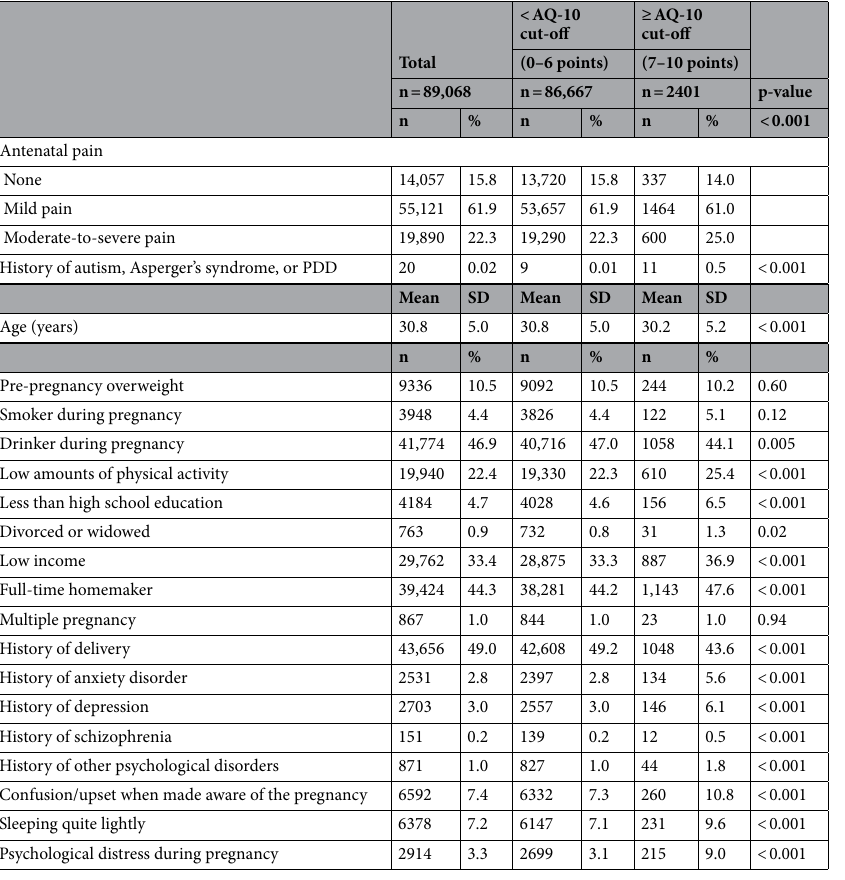
Table 1. Participants’ characteristics by the Autism-Spectrum Quotient short form (Japanese version) cut-off point (N = 89,068). AQ-10 Autism-Spectrum Quotient short form, PDD pervasive developmental disorders, SD standard deviation. Criteria for developmental disorders in the questionnaire were based on the Diagnostic and Statistical Manual of Mental Disorders, Fourth Edition (DSM-IV). Body mass index ≥ 25 kg/m 2 was defined as overweight. The first quintile of amounts of physical activity was defined as low amounts of physical activity. Equivalized income < 1.22 million Japanese yen was defined as low income. A Kessler Psychological Distress Scale (K6) score ≥ 13 was interpreted as indicating the presence of psychological distress during pregnancy. T-tests were used to compare groups on continuous variables. Chi-square analyses were conducted for categorical